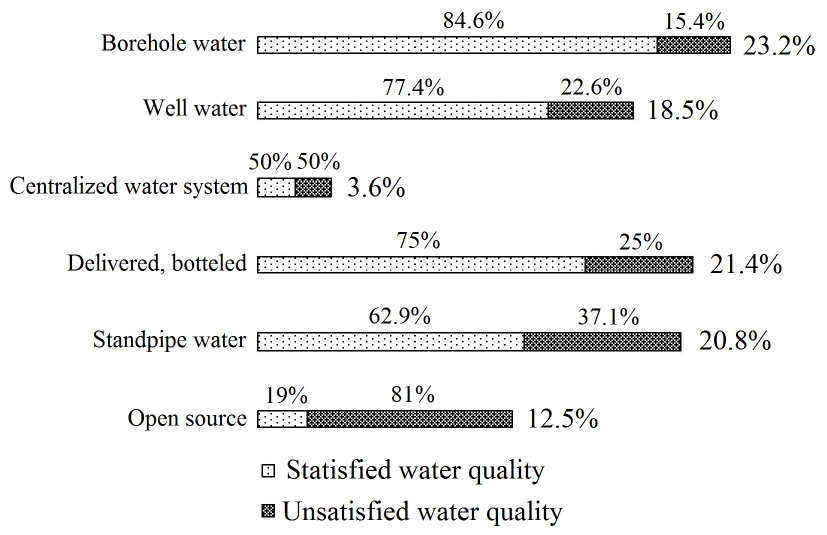
Figure 1. Drinking water users’ perception of water